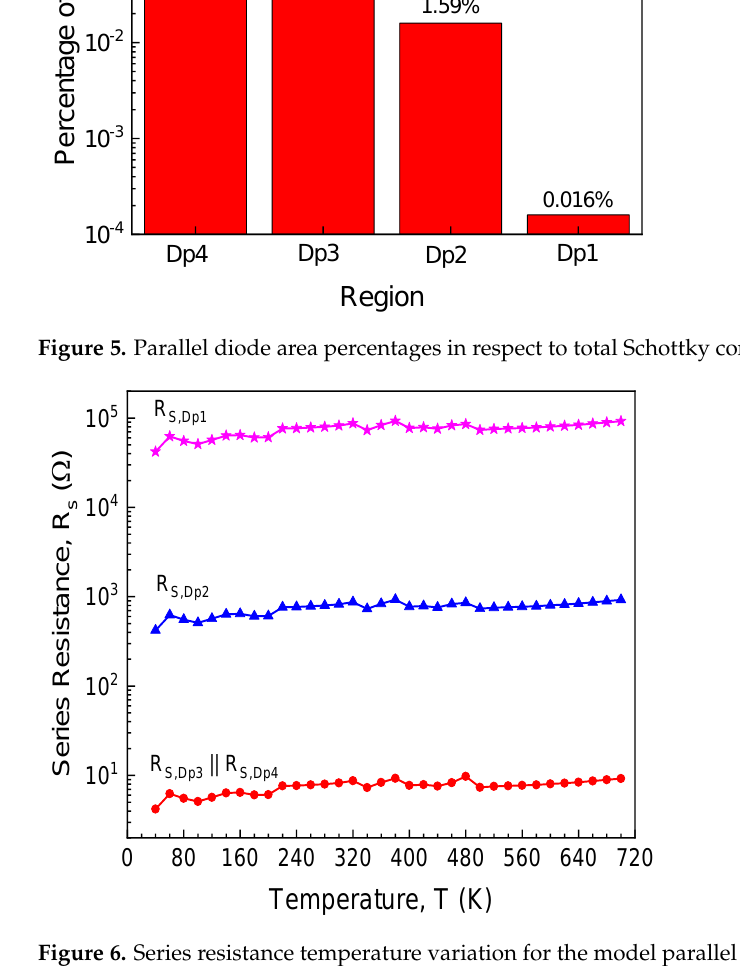
Figure 6. Series resistance temperature variation for the model parallel diodes (Dp1–Dp4). The model-fitted forward curves, also depicted in Figure 4 (lines), are in good agree- ment with measurements for the entire temperature span. The fitting used Equation (7) with m = 4, the parameters from Table 1, and R S data from Figure 6. Notably, the ideality factor, n = 1.01, was considered for each parallel diode, in the full 60–700 K domain. Dp3 and Dp4 significantly affect total current at all temperatures, especially in the high-bias region. Dp1 and Dp2 only influence conduction in the low-bias, low-temperature portion of the forward characteristics. Their impact becomes negligible past 200 K. For this investi- gated sample, our model [40] was able to completely reflect experimental forward behavior even at cryogenic temperatures (Figure 4). This is because, due to their area sizes which add up to almost the entire nominal surface (Figure 5), none of the parallel diodes suffers from the “pinch-off” effect [41]. This result attests to the high uniformity of the Schottky metal (Ni 2 Si, see Figure